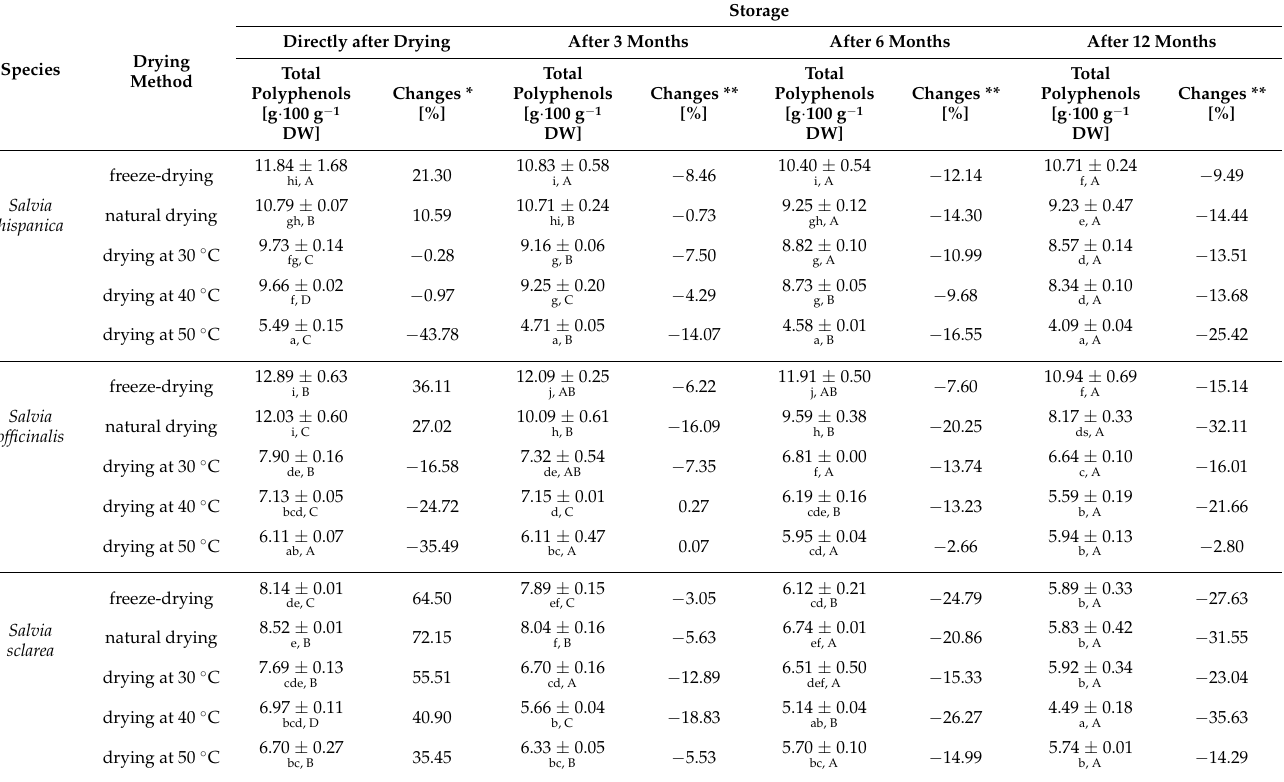
Results are expressed as mean ± SD ( n = 3). DW—dry weight. Mean values with different letters (a–j) within the individual storage periods (columns) are statistically different ( p < 0.05). Mean values with different letters (A–D) within the individual species of sage and drying methods (rows) are statistically different ( p < 0.05). * Changes in the content of total polyphenols with reference to fresh sage samples. ** Changes in the content of total polyphenols with reference to sage samples directly after